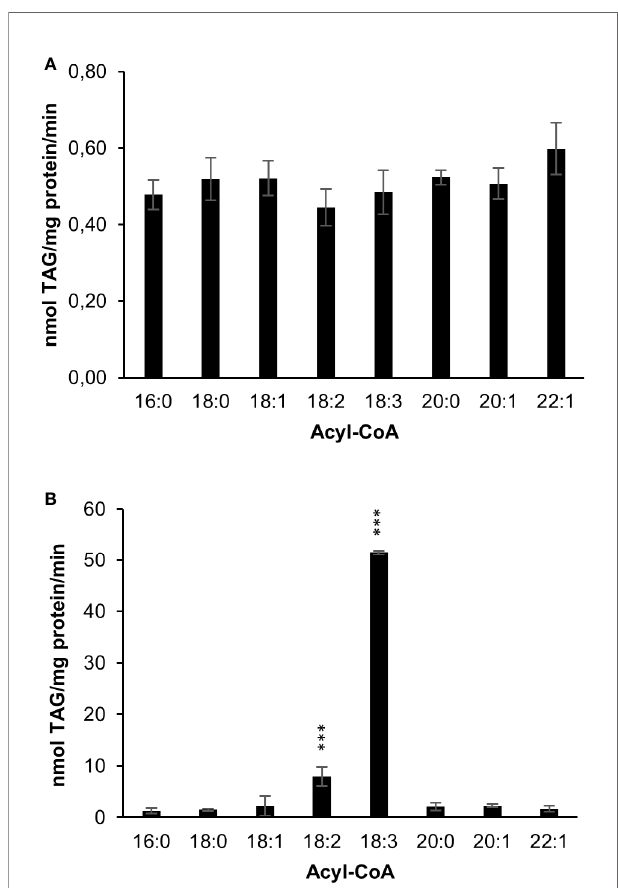
FIGURE 2 | Acyl-CoA speci fi cities of C. sativa DGAT enzymes in microsomal preparations from yeast expressing the enzymes, when fed [ 14 C]glycerol labeled di-6:0-DAG and different acyl-CoAs. (A) DGAT1 and (B) DGAT2. Average value shown ± SD, n=3 replicates. Stars over individual bars indicate signi fi cant differences according to one-way ANOVA followed by Tukey ’ s test. ***p ≤